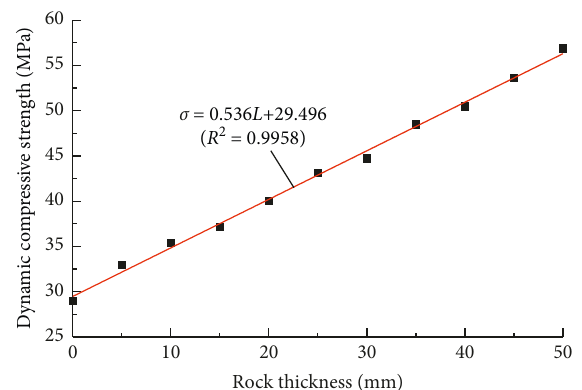
Figure 5: Fitting line of rock thickness and dynamic compressive strength change.